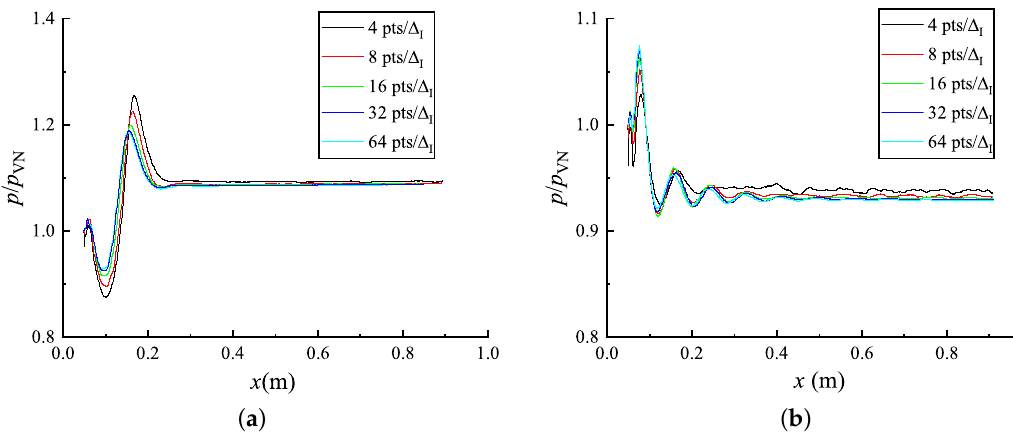
Figure 3. Numerical resolution test for one-dimensional detonations, ( a ) k R = 2.0 s − 1 , T 1 = 270 K and ( b ) k R = 4.0 s − 1 , T 1 = 320